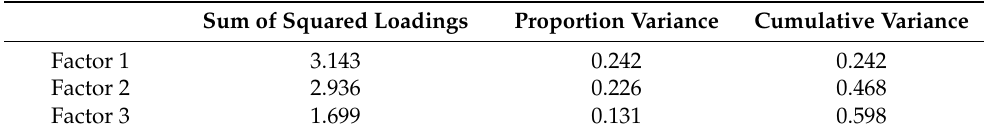
Table 4. Factor characteristics a .